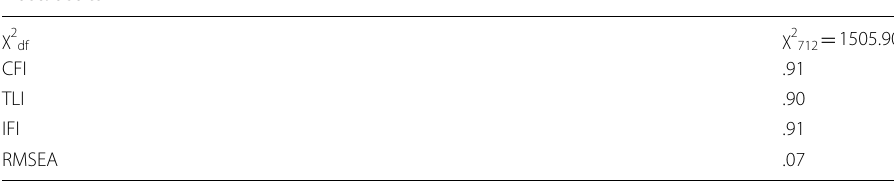
CHA Challenge, ACI Achievement, AVC Avatar customization, AVI Avatar identification, SOP Social presence, SOS Social support, COM-N Competence need fulfillment, AUT-N Autonomy need fulfillment, REL-N Relatedness need fulfillment, CI Intention to continuously use a VR fashion app, PI Intention to make in‑app purchases